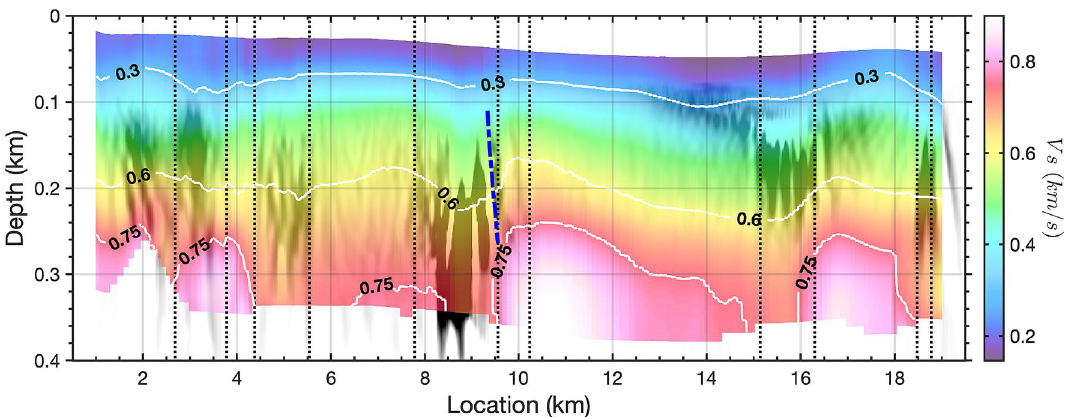
Figure 9. Integrated results using V s inversion and backscattered Scholte wave migration. The background gray image shows the natural migration result; the front color image shows the V s inversion profile; the blue dashed line represents the Kirchoff migration result. The black dashed lines indicate the observed horizontal discontinuity from autocorrelation image. Shear-wave velocity model contours are shown in units of